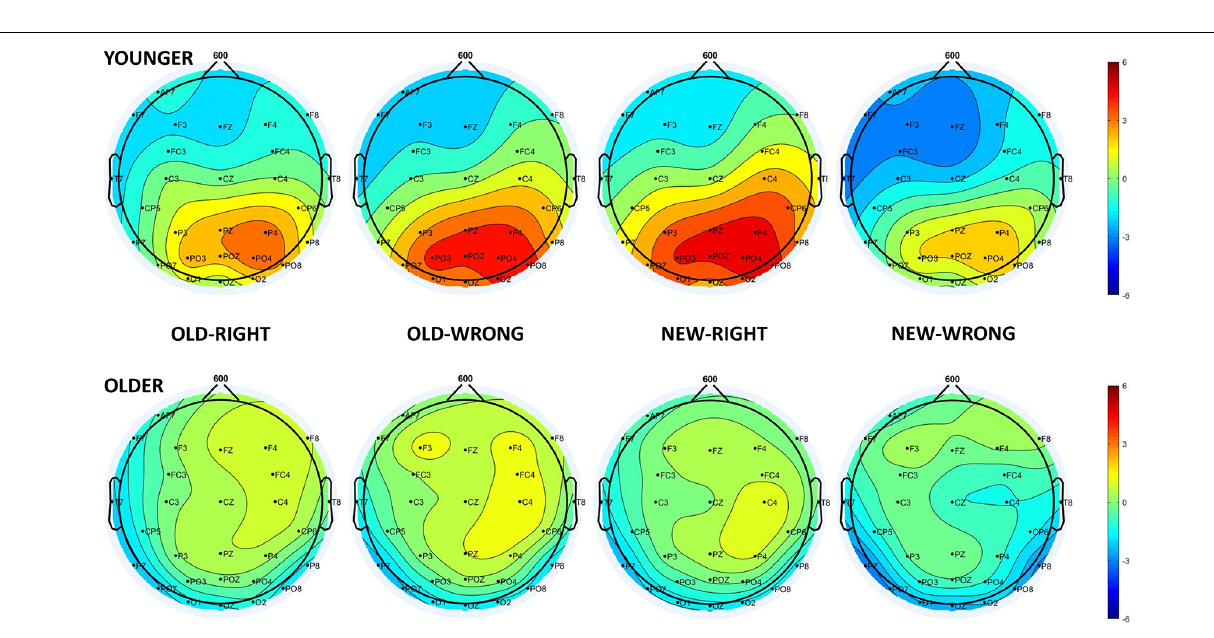
FIGURE 5 | Scalp distribution of the LPC in younger (top panel) and older adults (bottom panel) for the four test responses in the following order: Old-Right, Old-Wrong, New-Right,